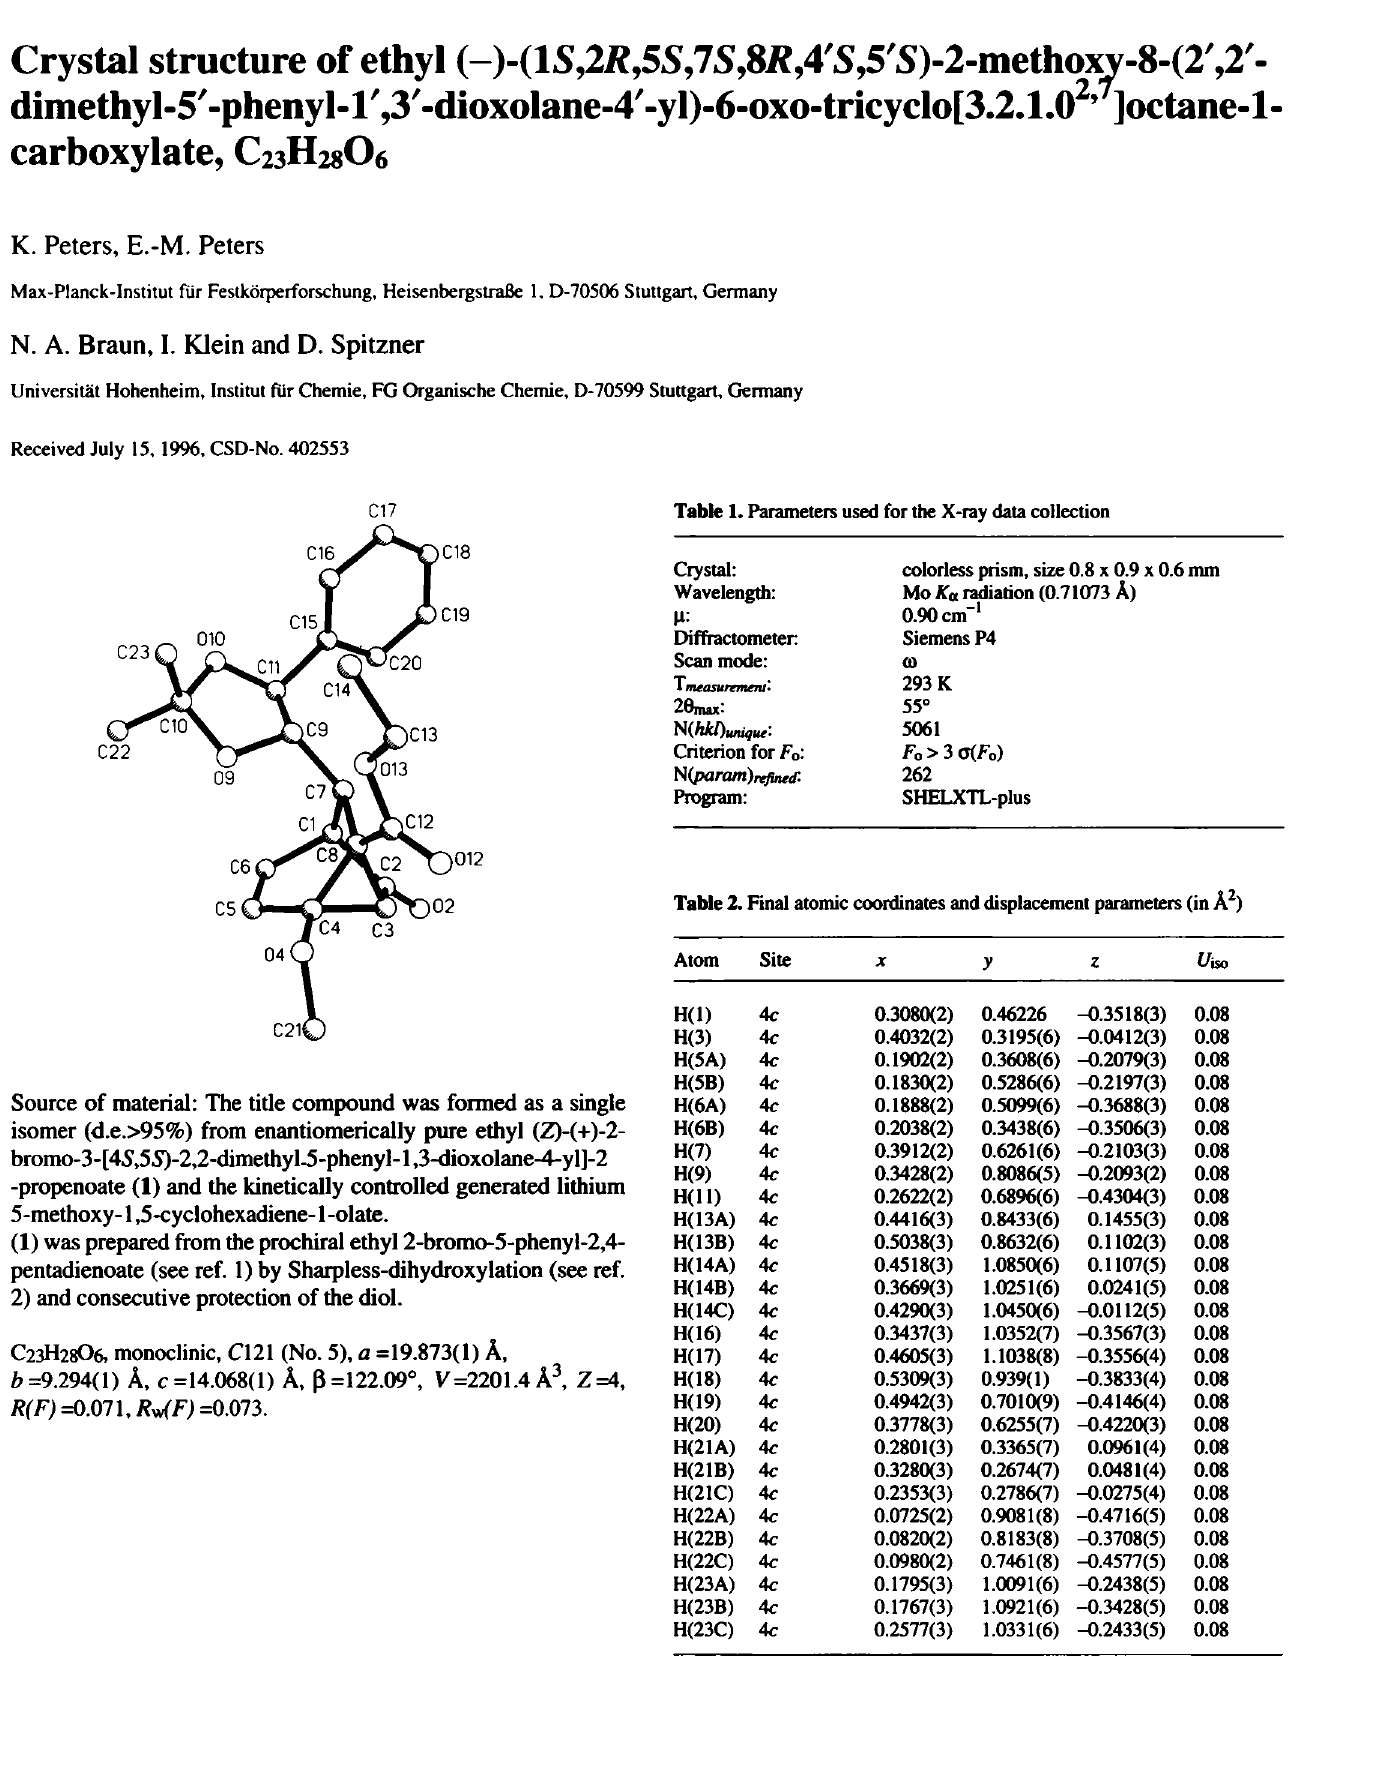
Table I. Parameters used for the X-ray data collection Crystal: